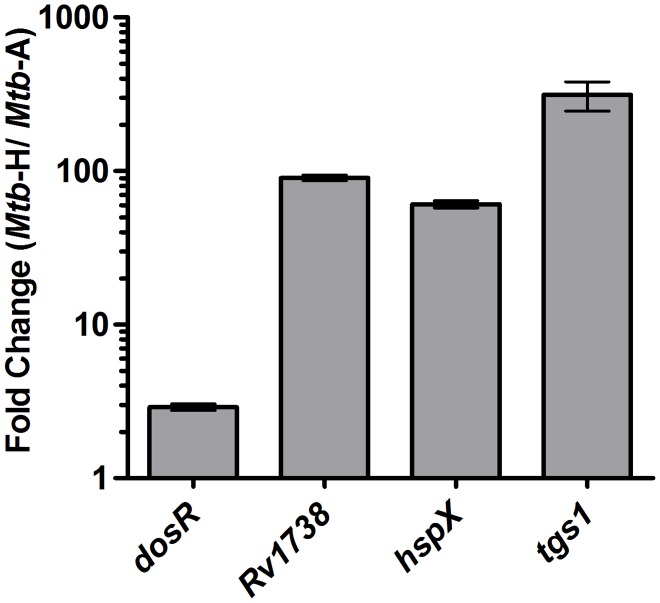
Induction of the DosR-regulon upon culturing Mtb in hypoxia.The devR transcripts and DevR protein dependent ‘devR regulon’ transcripts (e.g. Rv1738, hspX and tgs1 transcripts, ref. 41) in Mtb cultures grown under hypoxic (30 days) versus aerobic conditions is shown. Fold induction of dosR regulon genes in Mtb-H vs. Mtb-A bacterial cultures obtained by Real-time RT-qPCR performed in triplicates is expressed as Mean ± standard deviation (SD); for dosR 2.90±0.13, Rv1738 90.25±3.96, hspX 60.81±3.43 and tgs1 are 313.32±67.84. Data were normalized using 16S ribosomal RNA as an invariant transcript and calculated as fold induction using delta-delta Ct method (ΔΔCt) (ref. 21).